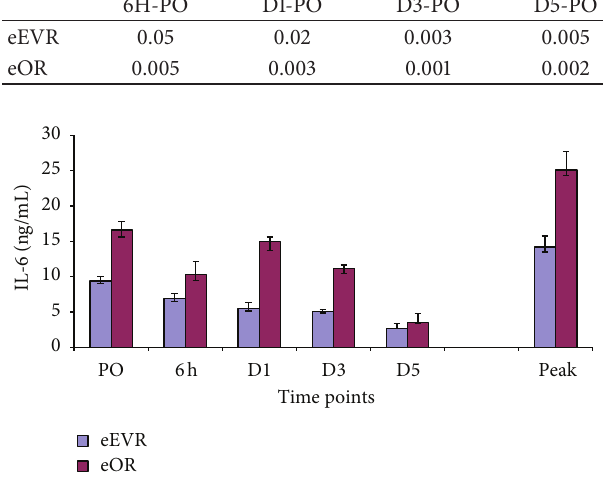
Figure 1: Plasma IL-6 levels expressed as median and interquartile range. At peak 𝑃 = 0.04 eEVR versus eOR; 6 h and D5 versus PO in eOE 𝑃 < 0.05 ; D3 versus PO in eEVR 𝑃 < 0.05 .